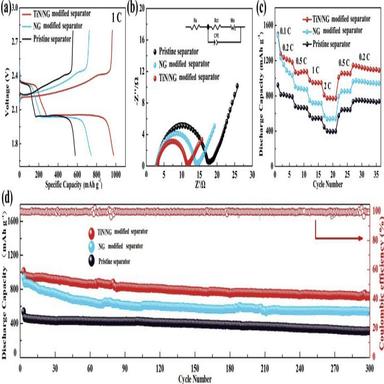
(a) Charge/discharge curves of the batteries with different separators at 1C. (b) EIS spectra of the batteries with different separators. (c) The rate performances of the batteries with different separators. (d) Cyclic performance of the batteries with different separators at 1C for 300 cycles.